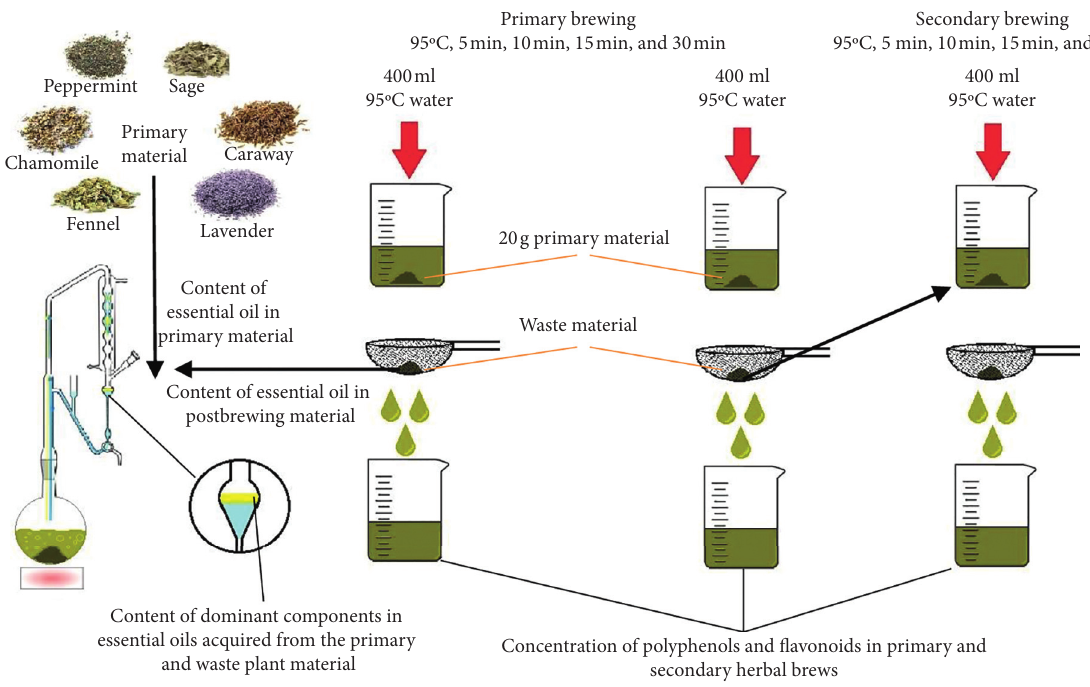
Figure 1: The procedure for sample preparation in the